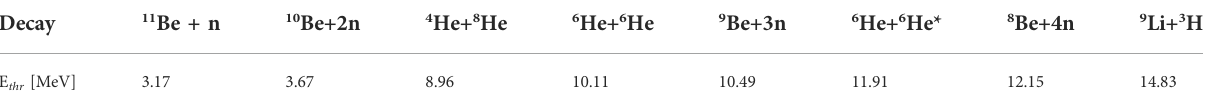
TABLE 5 Decay threshold energies of relevant decay channels for the 12 Be helium-decaying states.